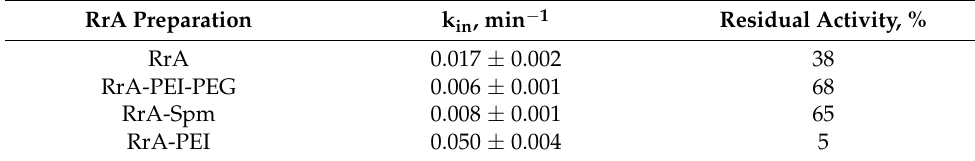
Table 6. Values of the first-order inactivation constants of RrA and its conjugates.